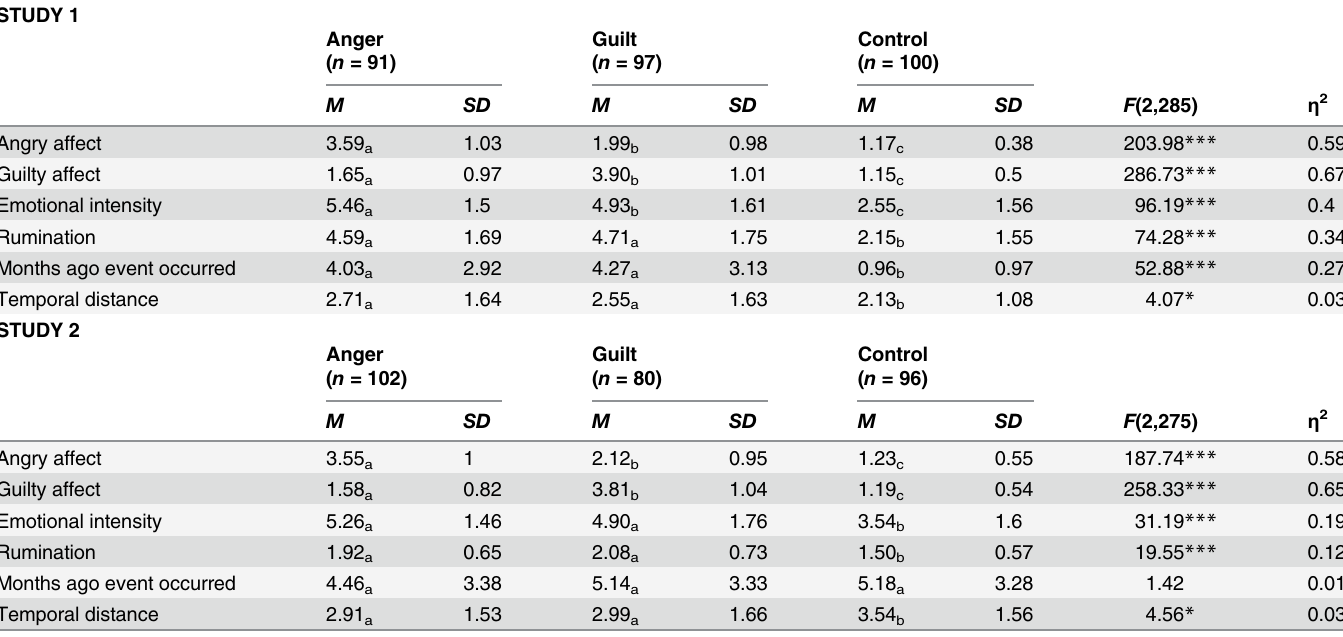
Table 1. Means and (standard deviations) of the measures from Studies 1 and